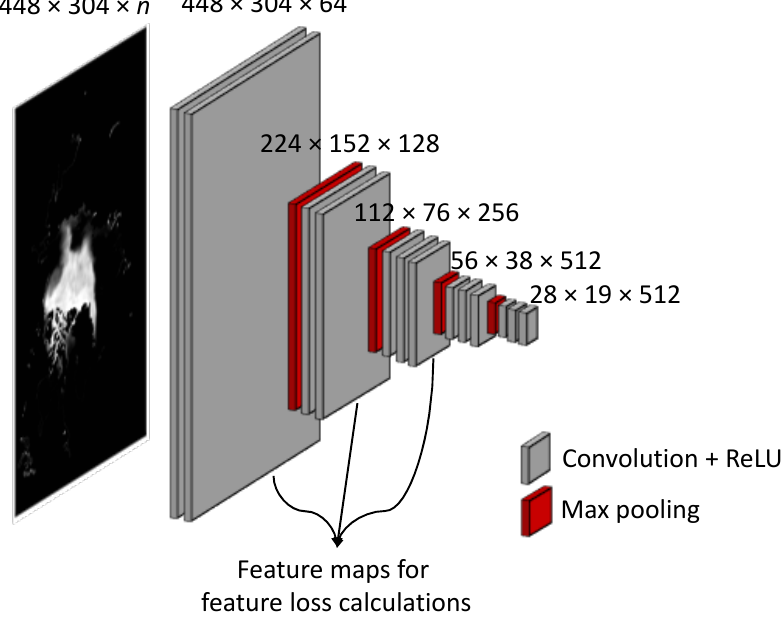
Figure 3. The architecture of VGG16 for the first five blocks. To calculate loss, we used feature maps from the last convolutional layer in the first three blocks.